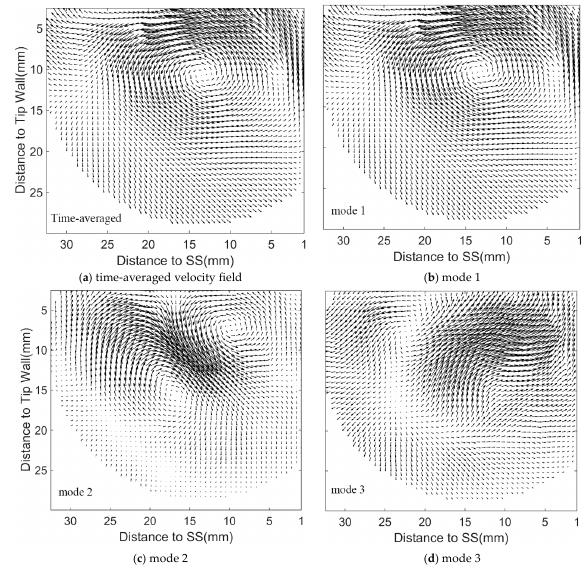
( d ) mode 3 Figure 16 . Time-averaged velocity vector field and spatial structures of mode 1, 2 and 3 in UV global analysis at L/c = 1.1.For simplicity, the spatial structures of UVW global analysis and UV component analysis have not shown.